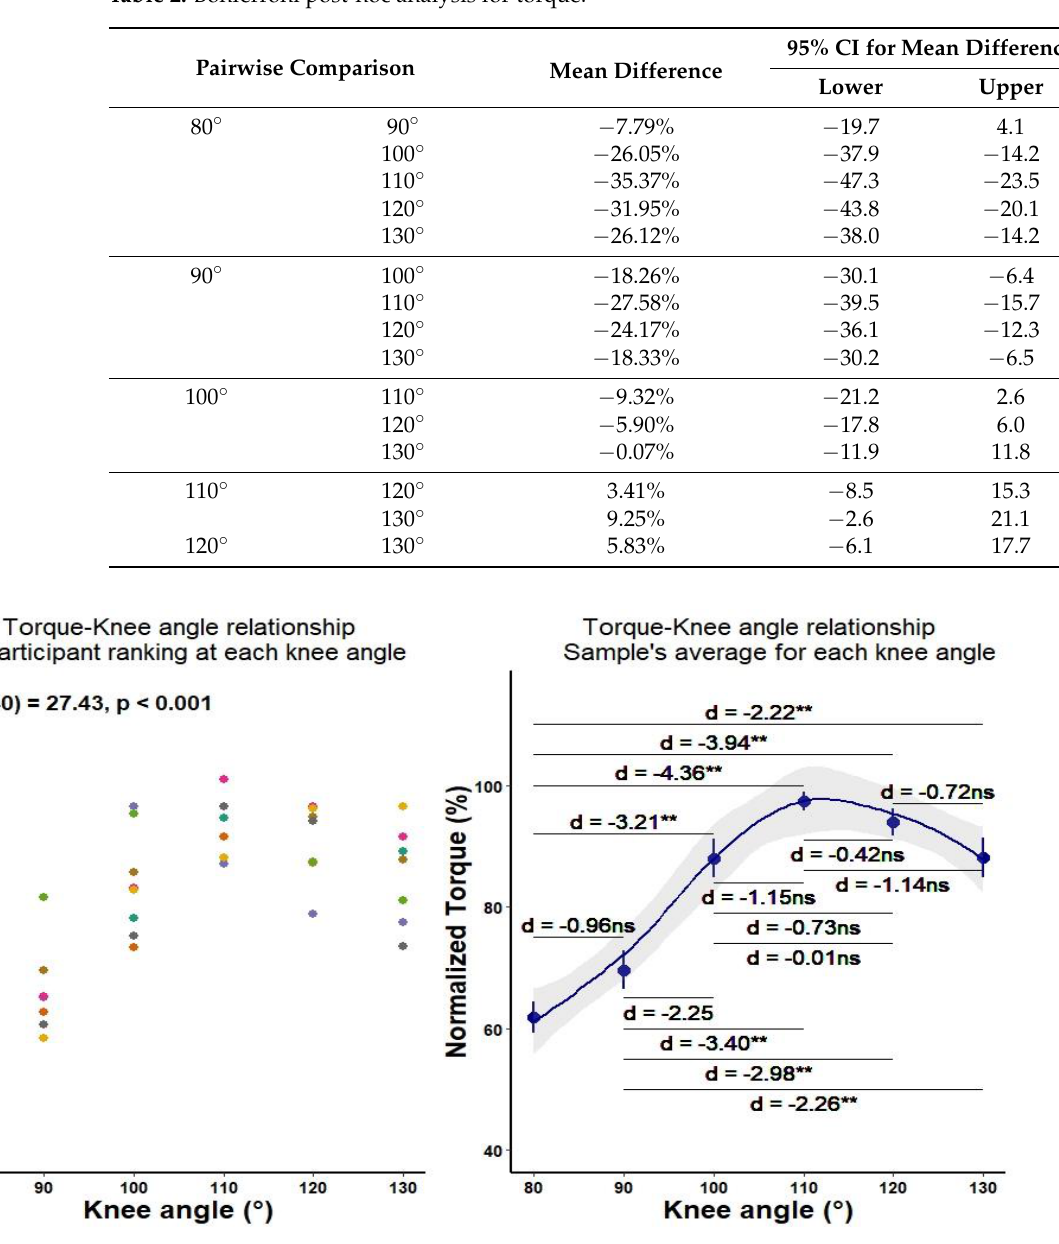
Figure 1. The effects of knee angle change on torque exertion. ** Significant at p < 0.01. Normalized EMG of VL and VM were not affected by the changes in knee angle (Figure 2). The individual variations in muscle activation at different knee joint angles and participant ranking indicate the ability of participants to similarly activate lateral and medial quadriceps heads across the selected knee angles.